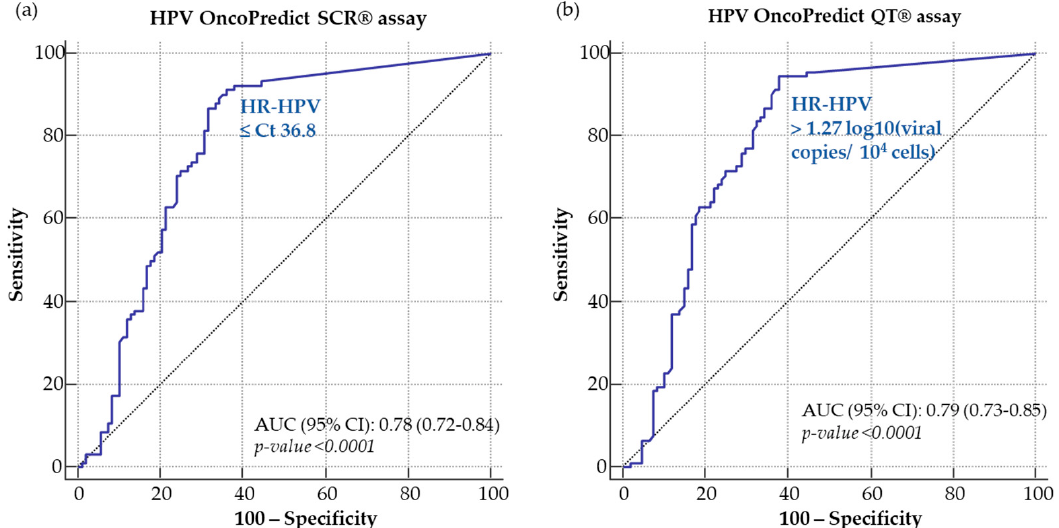
Figure 1. ROC curve analysis for the definition of cutoffs of HPV for OncoPredict HPV ® SCR ( a ) and QT ( b ) assays.